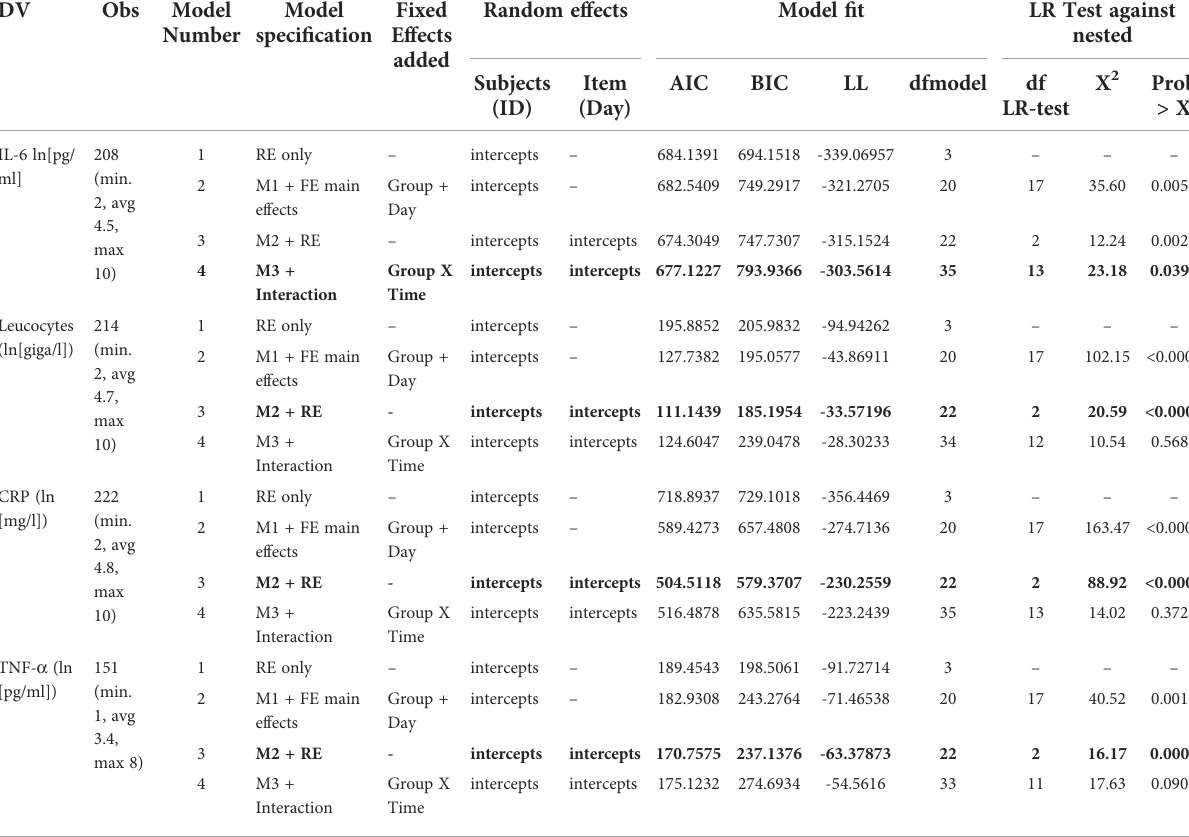
TABLE 2 Model comparison of intention-to-treat analysis by outcome (N =